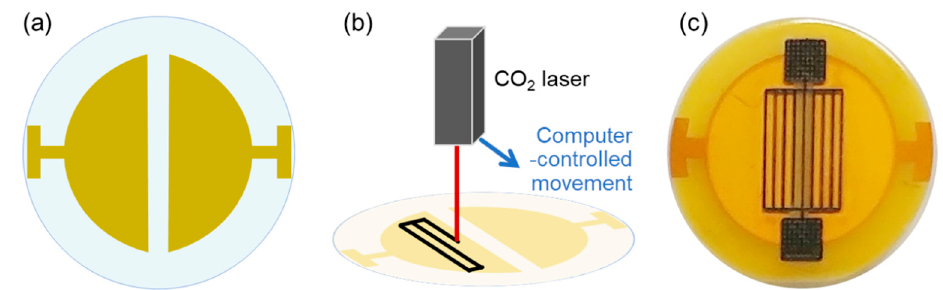
Figure 1. Schematic illustrations of the ( a ) lateral field excitation (LFE) pattern on the backside, ( b ) laser-induced graphene (LIG) process by CO 2 laser. ( c ) an image of polyimide (PI) film and LIG pattern on the front side of a quartz crystal microbalance